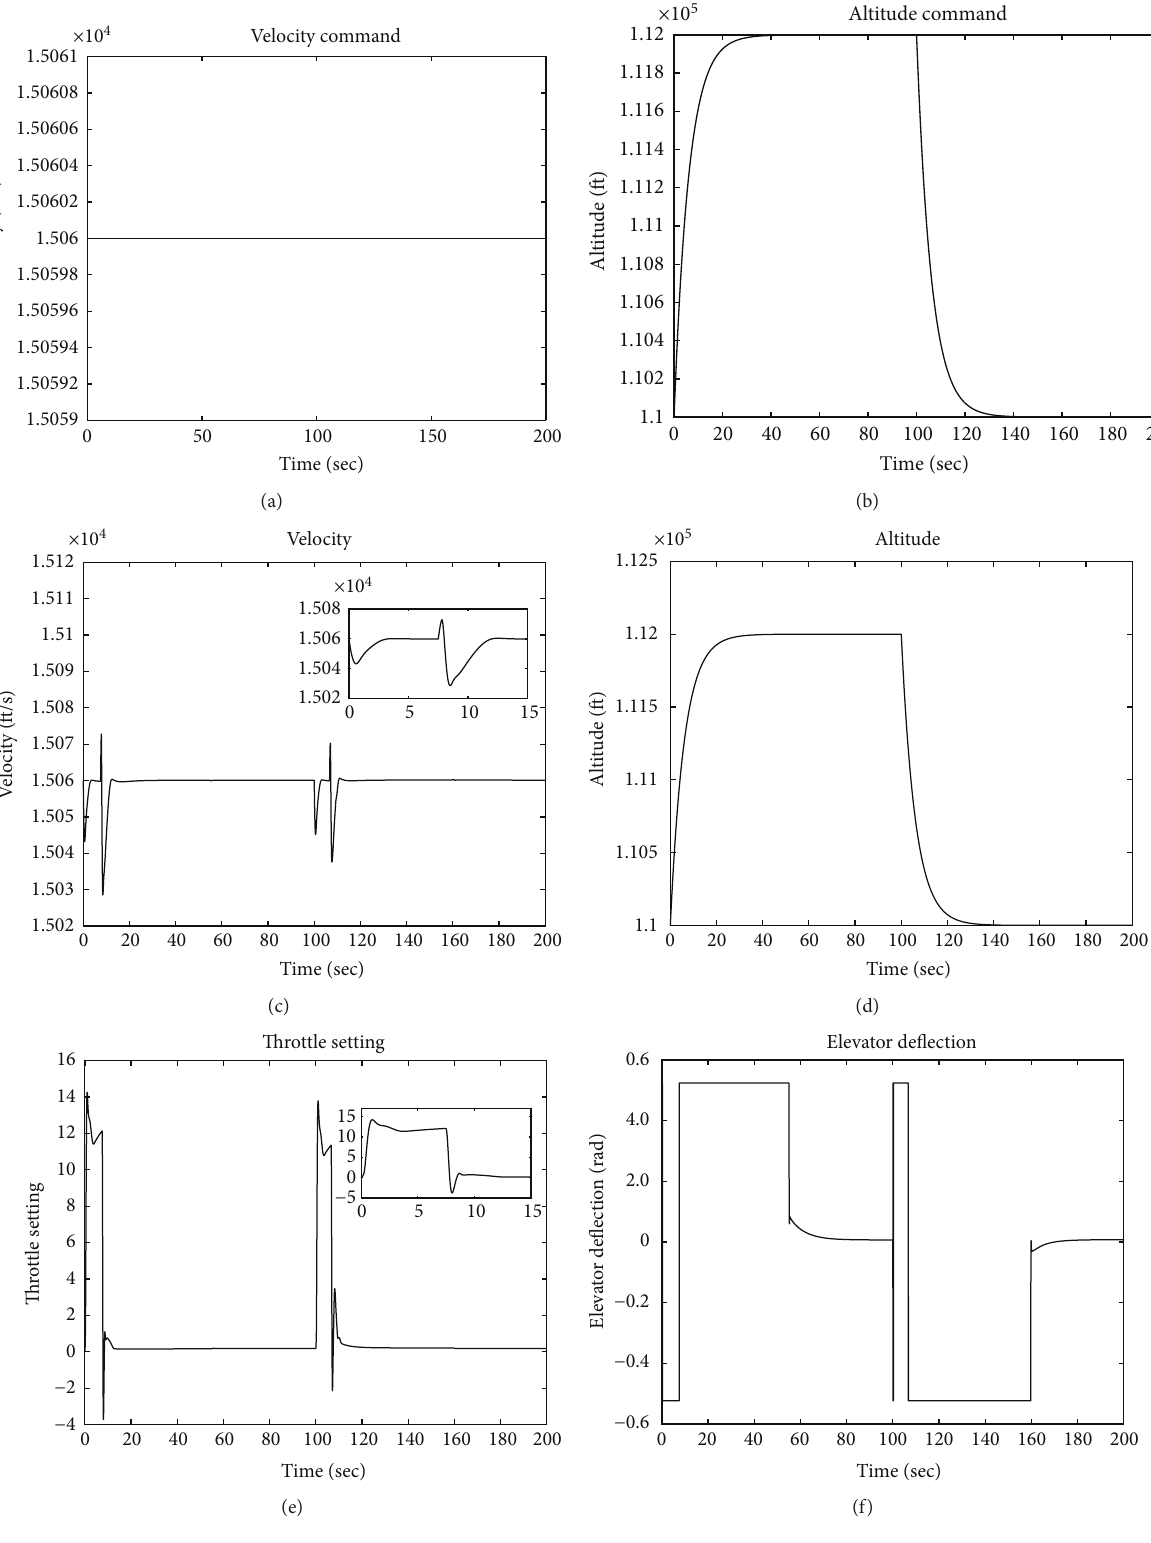
Figure 2: Altitude command, response, and controller. The uncertainty terms are added into the